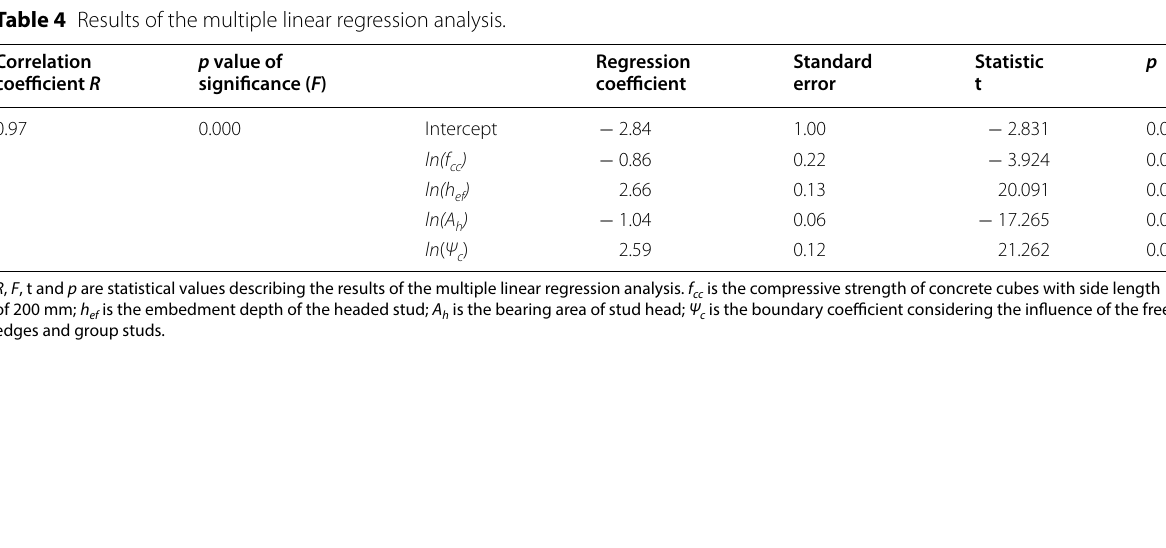
Table 4 Results of the multiple linear regression analysis.